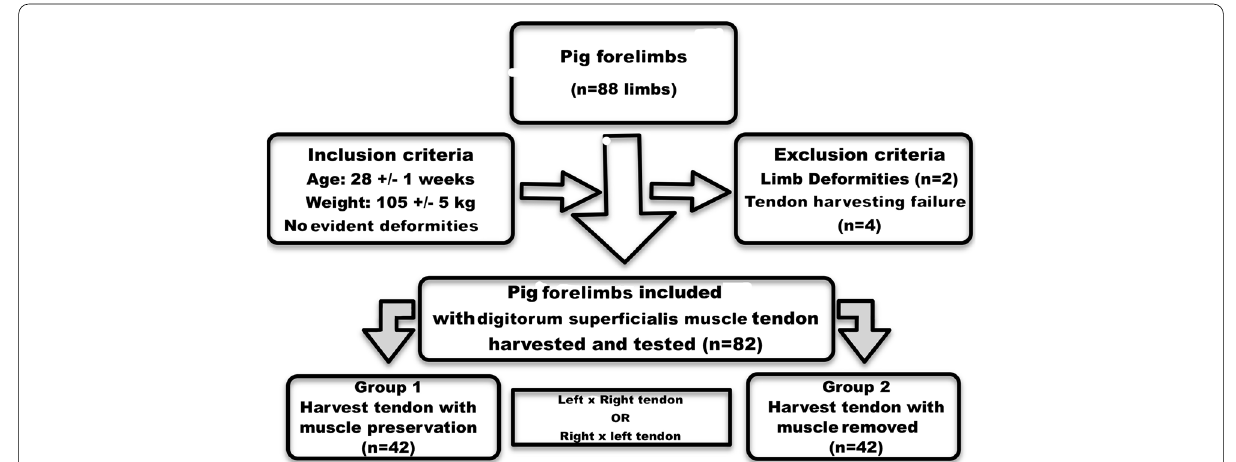
Fig. 1 Flowchart for the selection of limbs included in the evaluation. A total of 41 tendons were evaluated in each